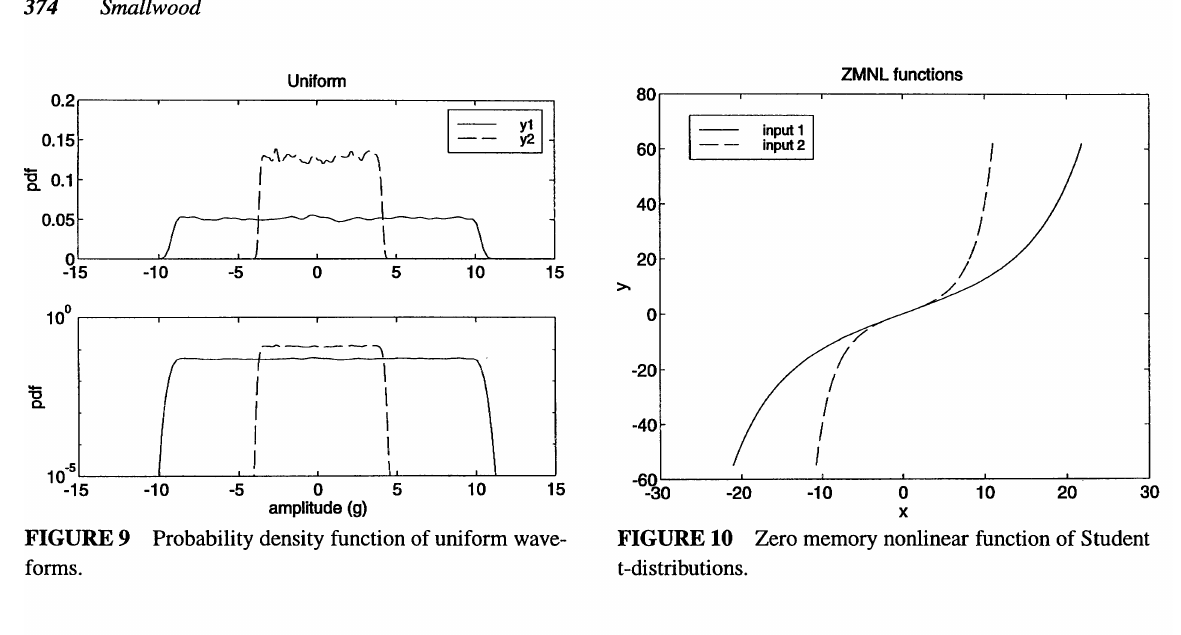
FIGURE 9 Probability density function of uniform wave- FIGURE 10 Zero memory nonlinear function of Student forms. t-distributions.